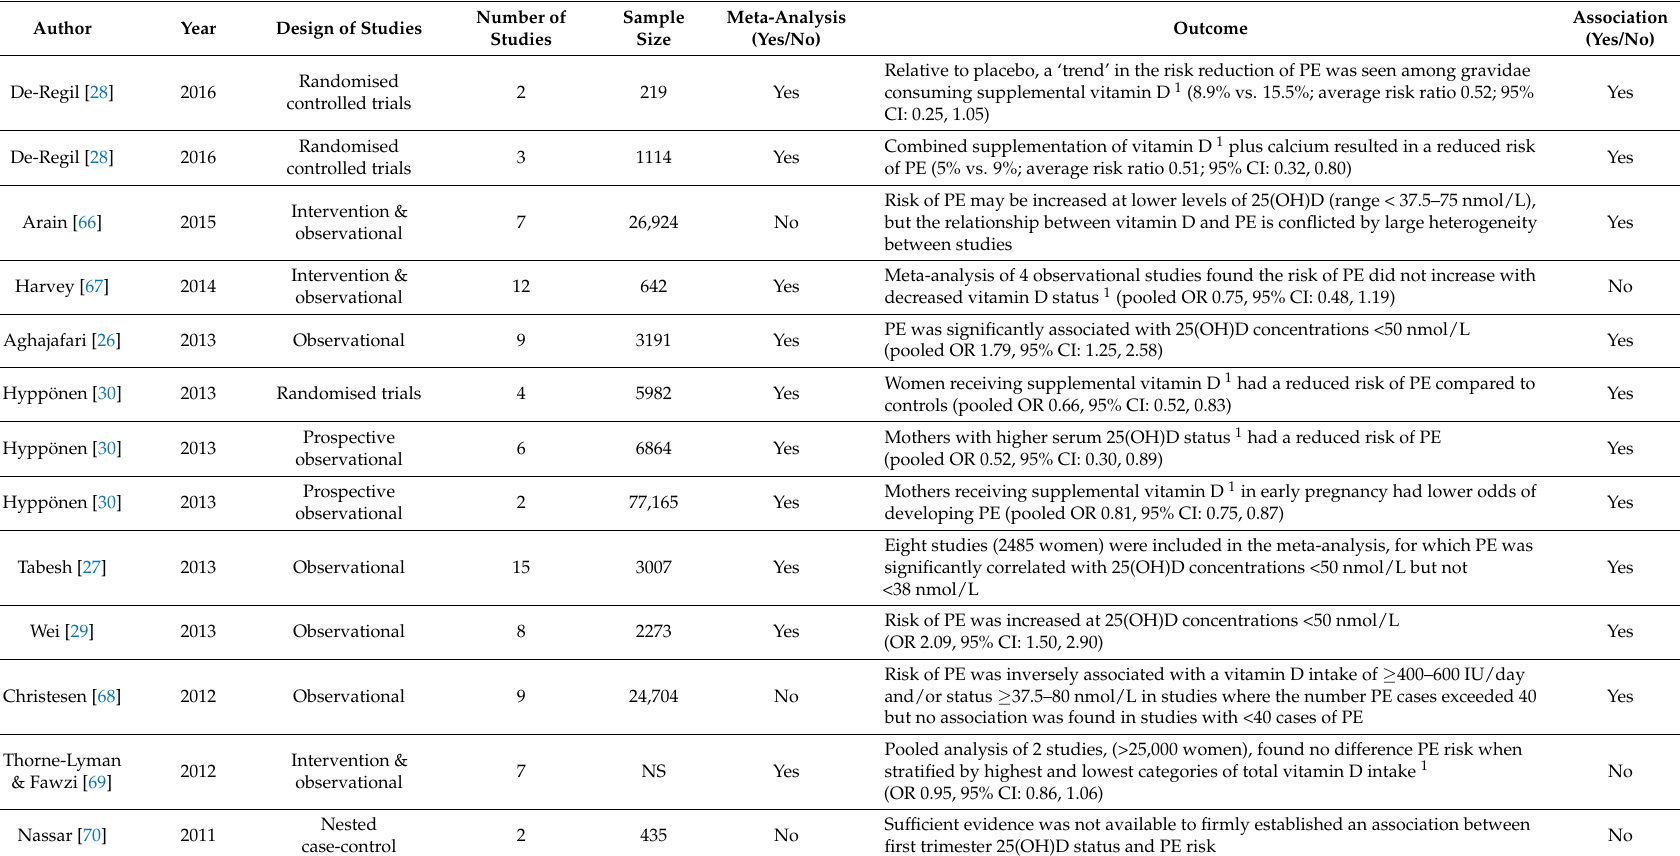
Table 3. Summary of recent systematic reviews examining the relationship of maternal vitamin D status and/or intake and risk of